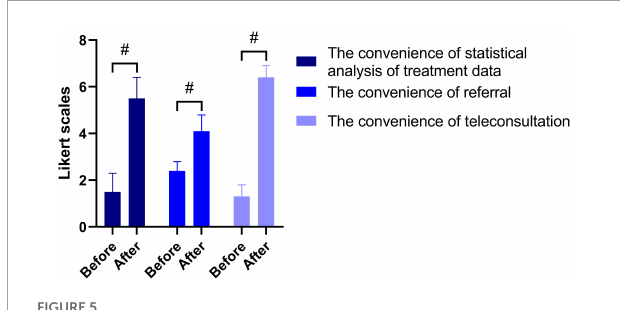
FIGURE5 Comparison of the convenience of daily work before and after project implementation. # P < 0.05.